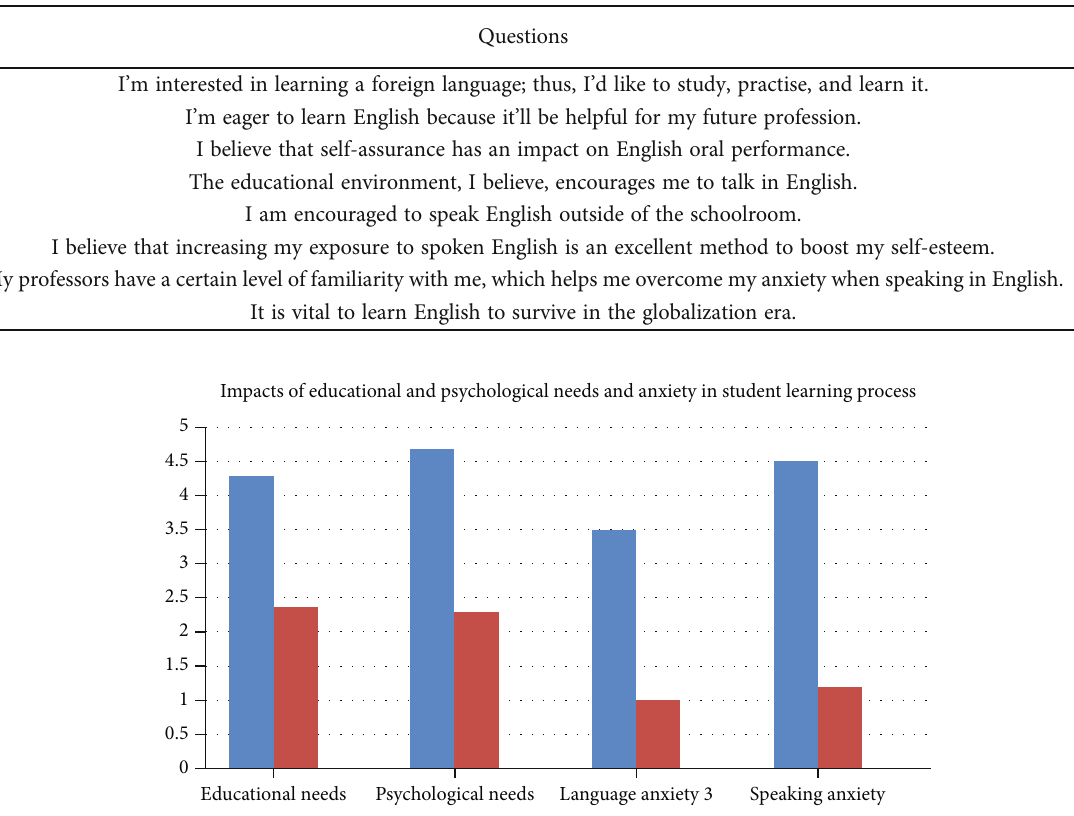
Table 2: Summarise the fi ndings from the Section